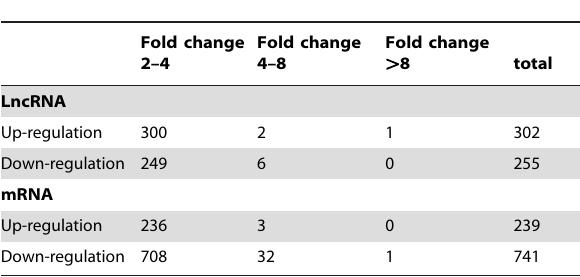
Table 2. Numbers of LncRNA and mRNA expressed differently between six pairs of VVs and paired NVs